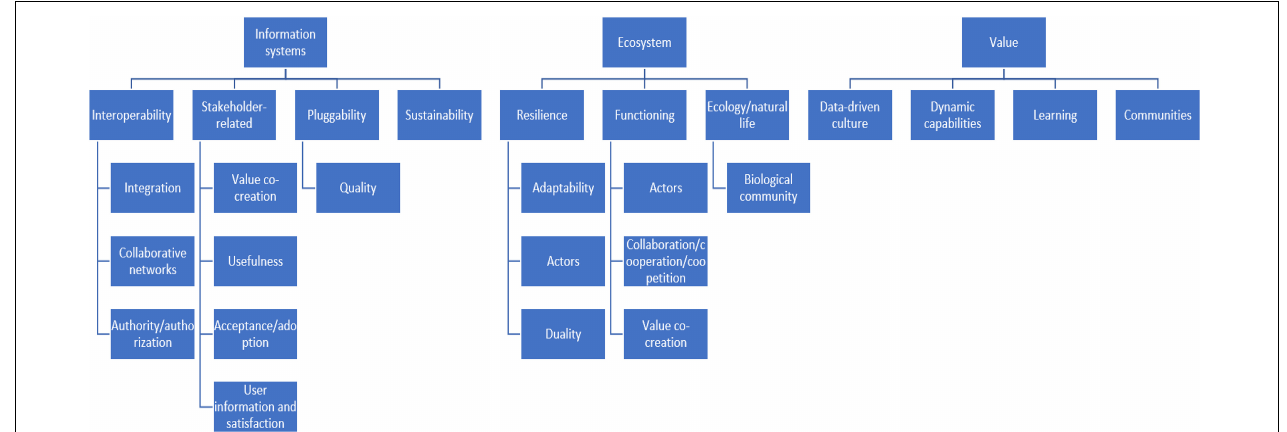
FIGURE 3 | Synthesis of concepts from the literature